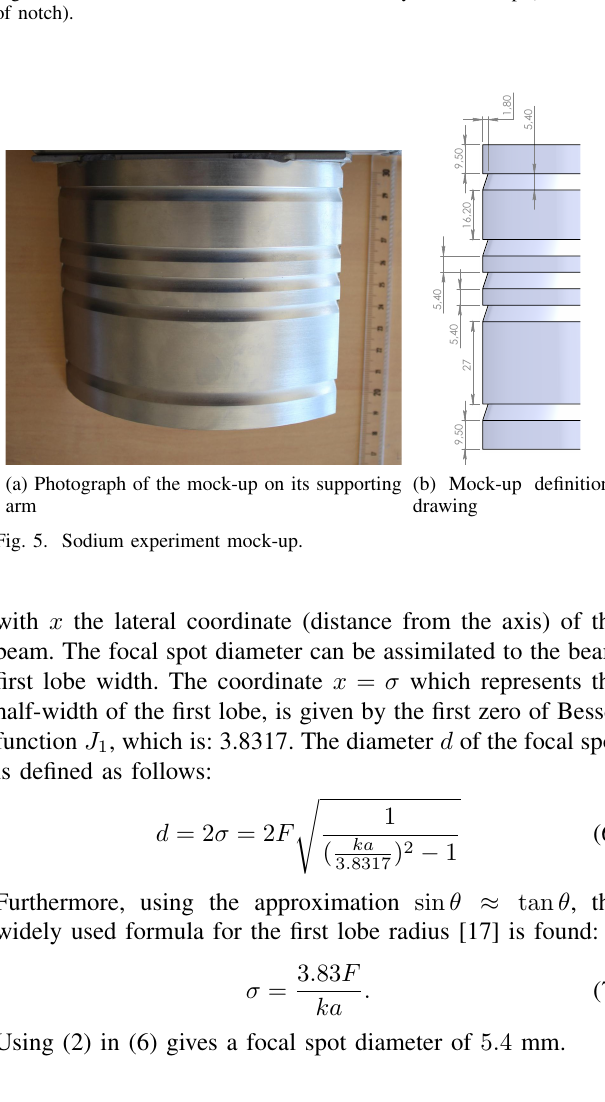
Fig. 6. One-dimensional C-scan of the sodium